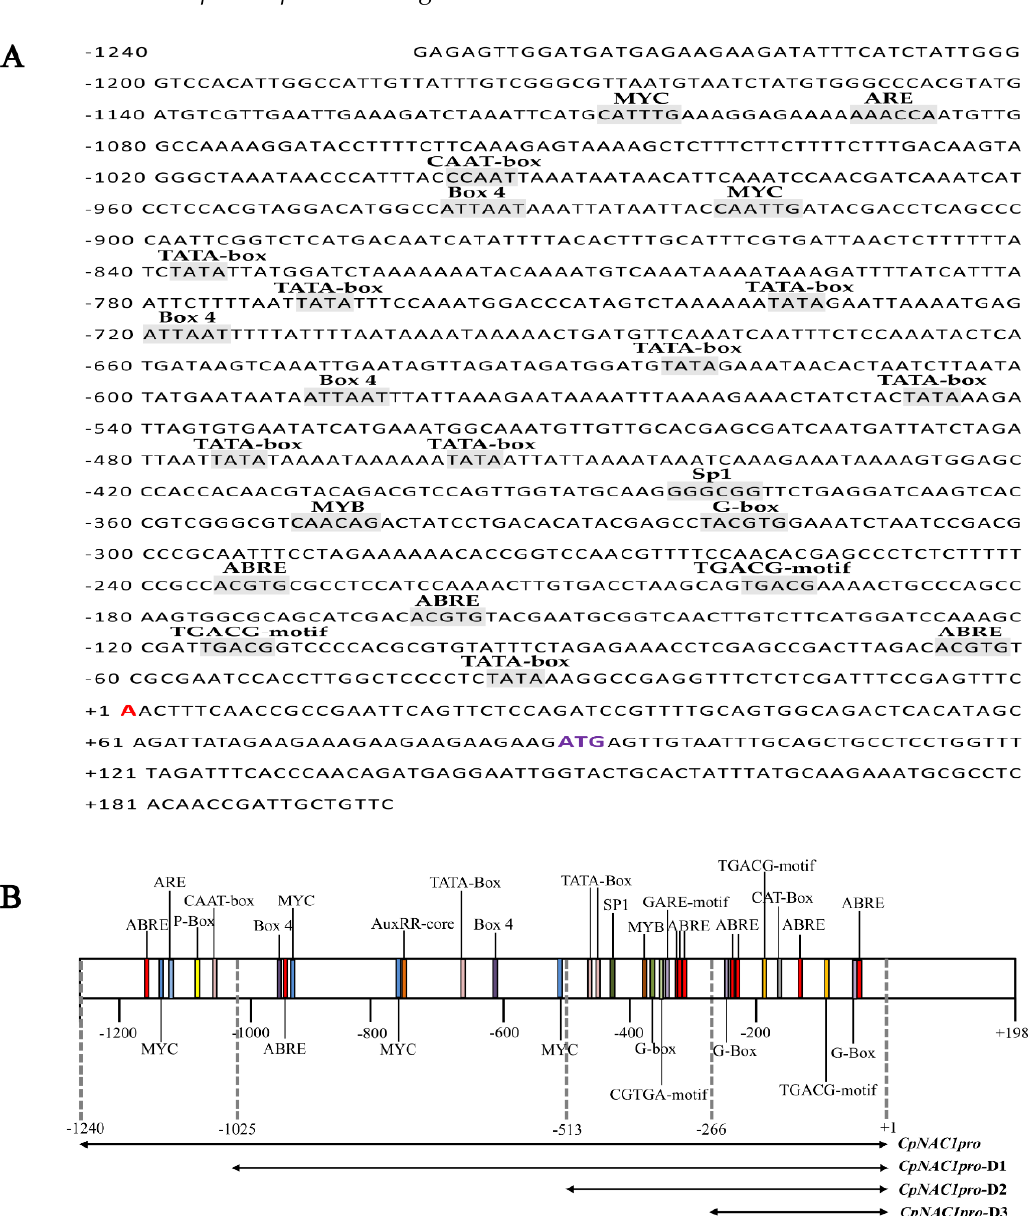
Figure 4. Isolated genomic DNA sequences and different segments with various cis -elements of CpNAC1 promoter. ( A ) Schematic diagram of the CpNAC1 promoter with putative cis -element sites. ( B ) Schematic diagram of CpNAC1 promoter divided into different segments. The dotted line indicates the position of the deletion segment: CpNAC1pro- D1, CpNAC1pro- D2, and CpNAC1 pro- D3.